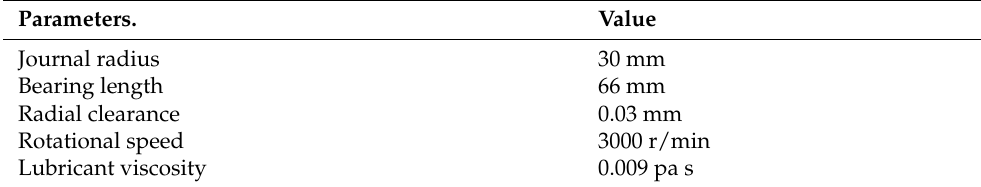
Table 1. Bearing parameters and lubricant properties from [33]. Parameters.